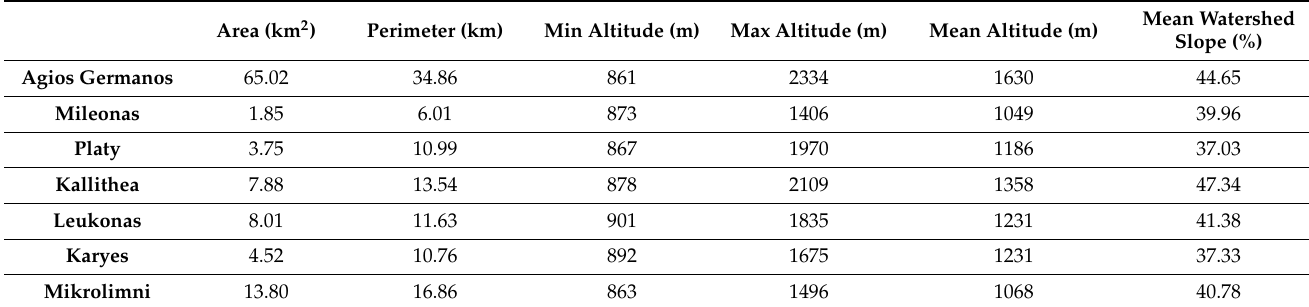
Table 1. Morphometric characteristics of the watersheds in the study area.